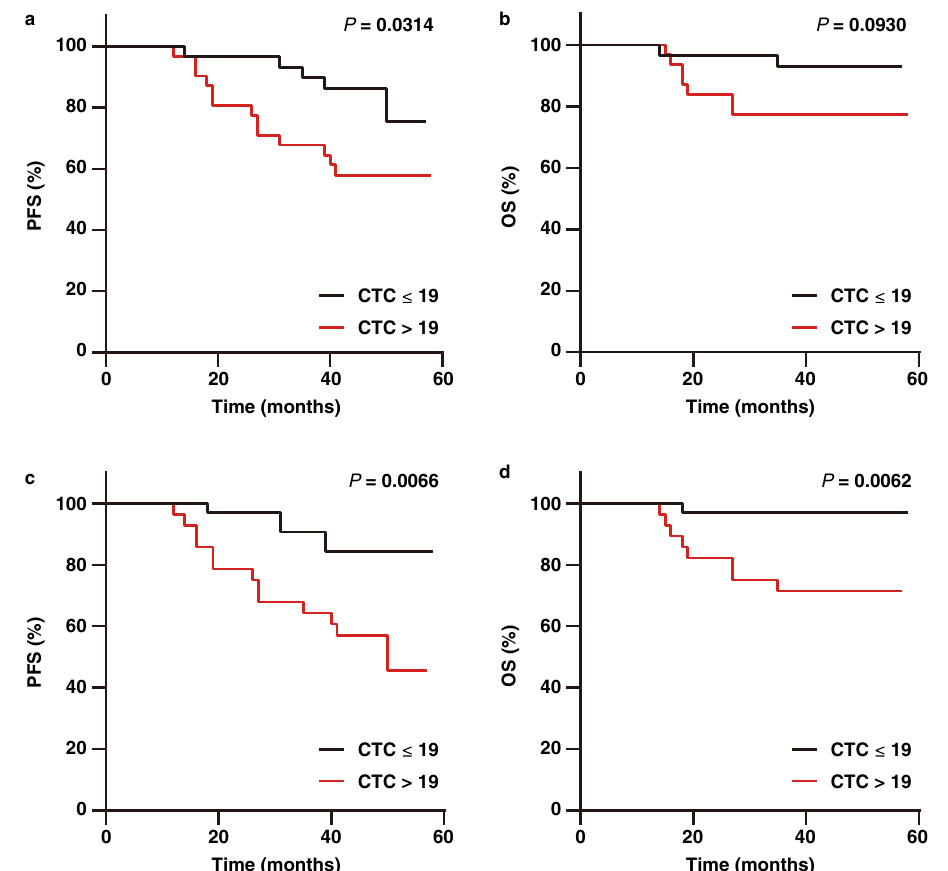
Figure 4. Kaplan–Meier curves showing estimated PFS and OS for patients with CTC negativity (CTC ≤ 19) and CTC positivity (CTC > 19) before initial chemotherapy ( a , b ) and before final chemotherapy ( c , d ).